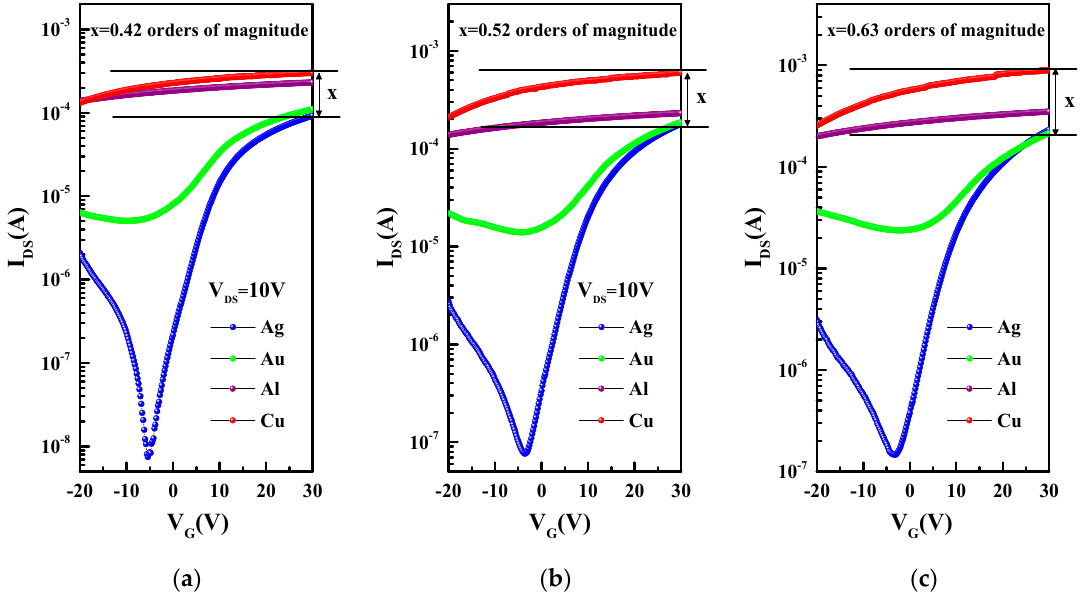
Figure 5. The comparison of the on-state current of MoS 2 devices with 4 different metallic electrodes at 3 different types of drain-source voltage of ( a ) 10 V; ( b ) 20 V; ( c ) 30 V.